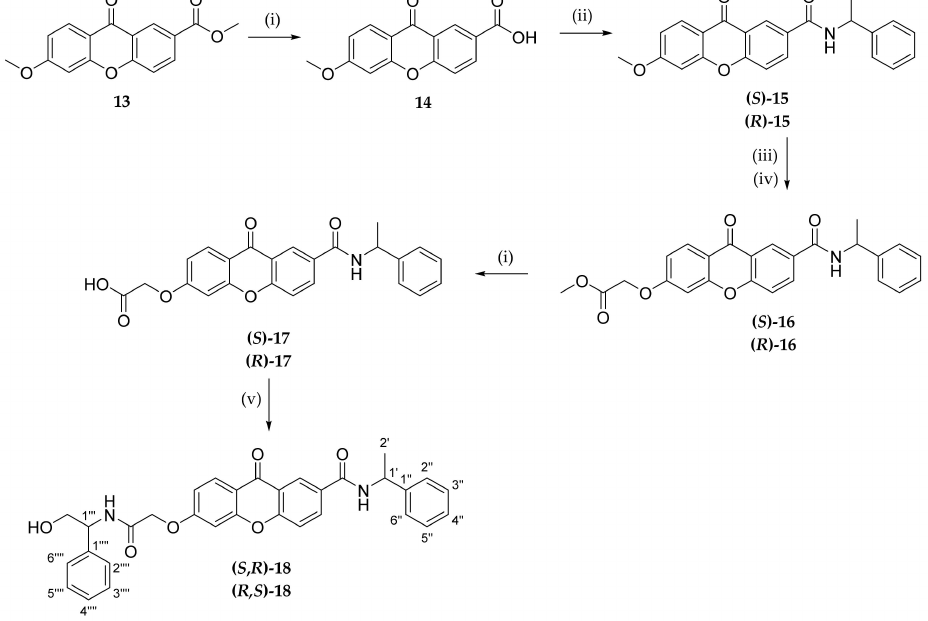
Scheme 2. Synthetic pathways for obtaining 2,6-substituted chiral derivatives of xanthones used in this study. (i) NaOH 5M, CH 2 Cl 2 :CH 3 OH (1:1 v/v ), rt, 5–22 h; (ii) ( R )-(+) or ( S )-( − )-( α )-methylbenzylamine, TBTU, anhydrous THF, TEA, rt, 1